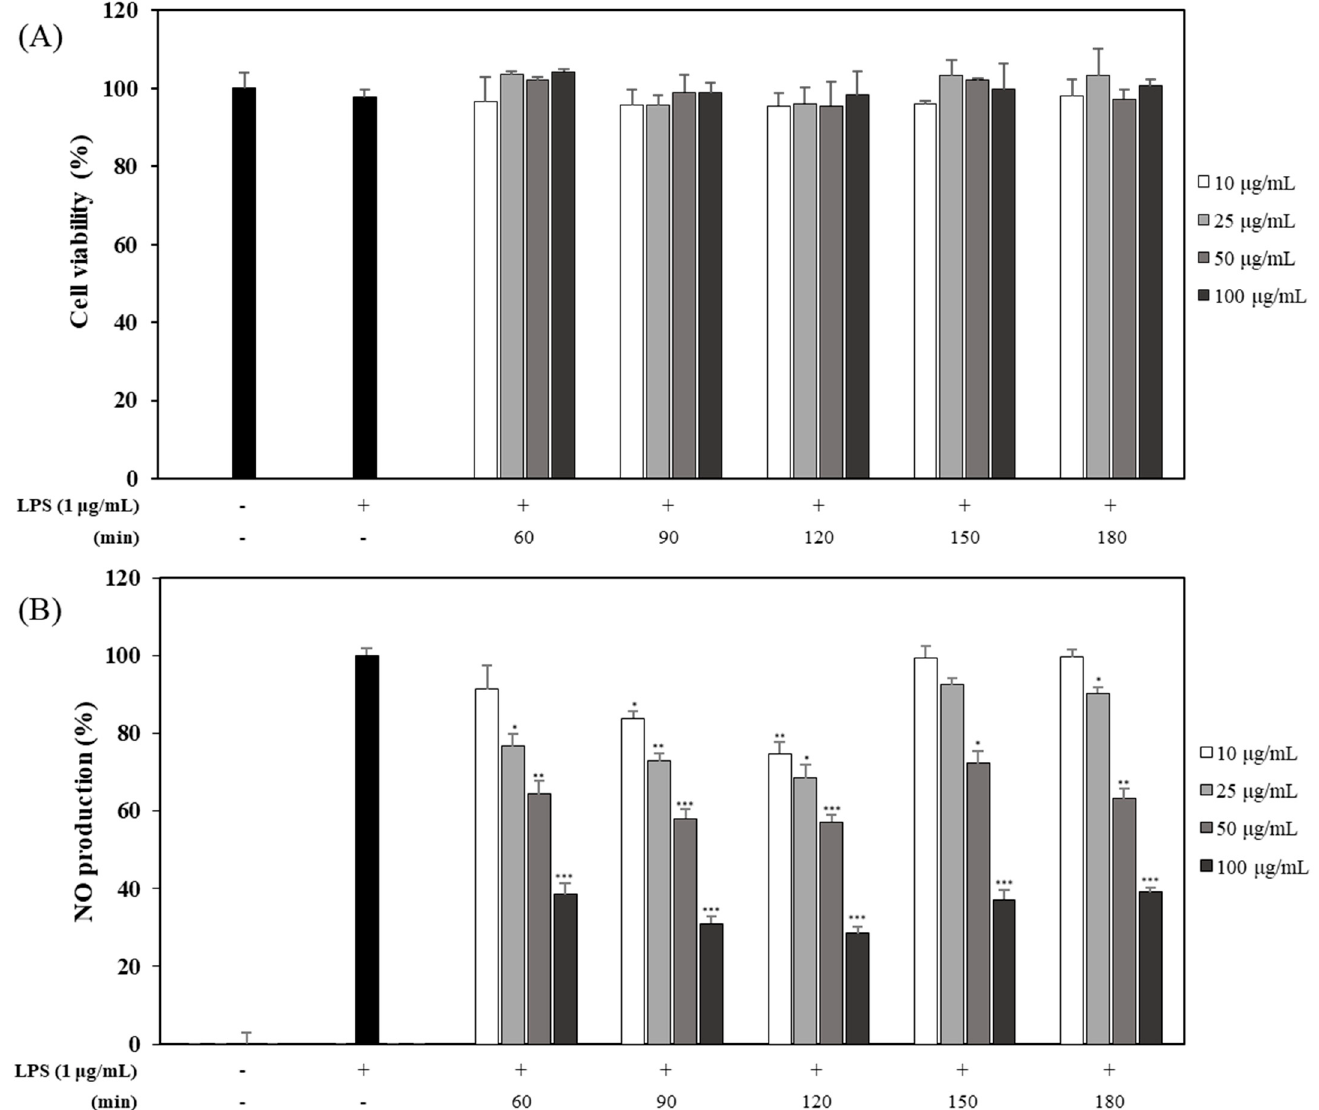
Figure 3. Effects of OFLEs obtained with various extraction time on cell viability and NO production. Effect of OFLEs (10, 25, 50, and 100 µ g/mL) obtained with different extract time (60, 90, 120, 150, and 180 min) on LPS-stimulated cell viability ( A ) and NO production ( B ) in mouse macrophages. Cells were cultured in the presence of OFLE at various concentrations for 1 h before stimulation with 100 µ g/mL LPS. At 20 h, the culture supernatant was assayed for cell viability and NO production. Values are presented as mean percentage ± SD of five samples from three different experiments compared with the corresponding LPS-induced control (100%). * p < 0.05, ** p < 0.01, *** p < 0.001 vs. LPS-treated group.